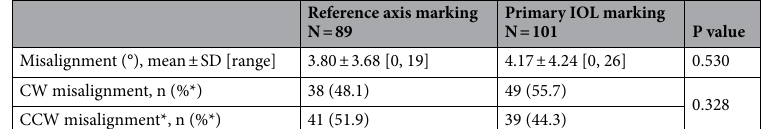
Primary IOL marking N = 101